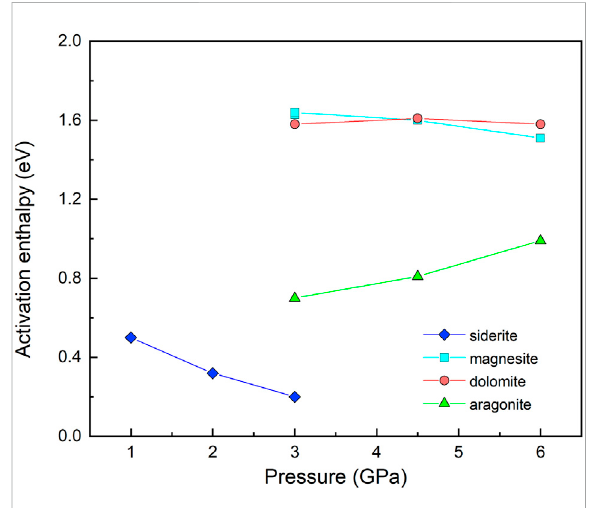
FIGURE 7 Activation enthalpies of carbonate minerals as a function of pressure before decarbonation reaction. The data of magnesite, dolomite and aragonite are from Mibe and Ono (2011), Ono and Mibe (2015), Ono and Mibe (2013),